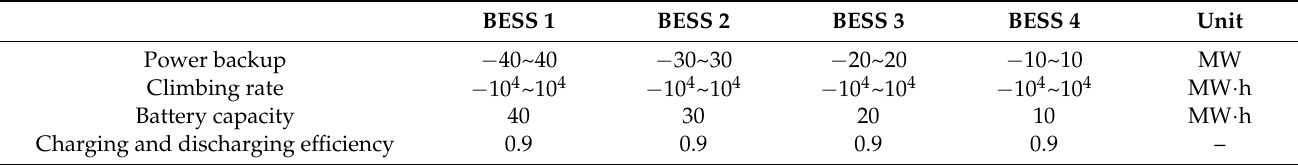
Table 3. Parameters of energy storage units.